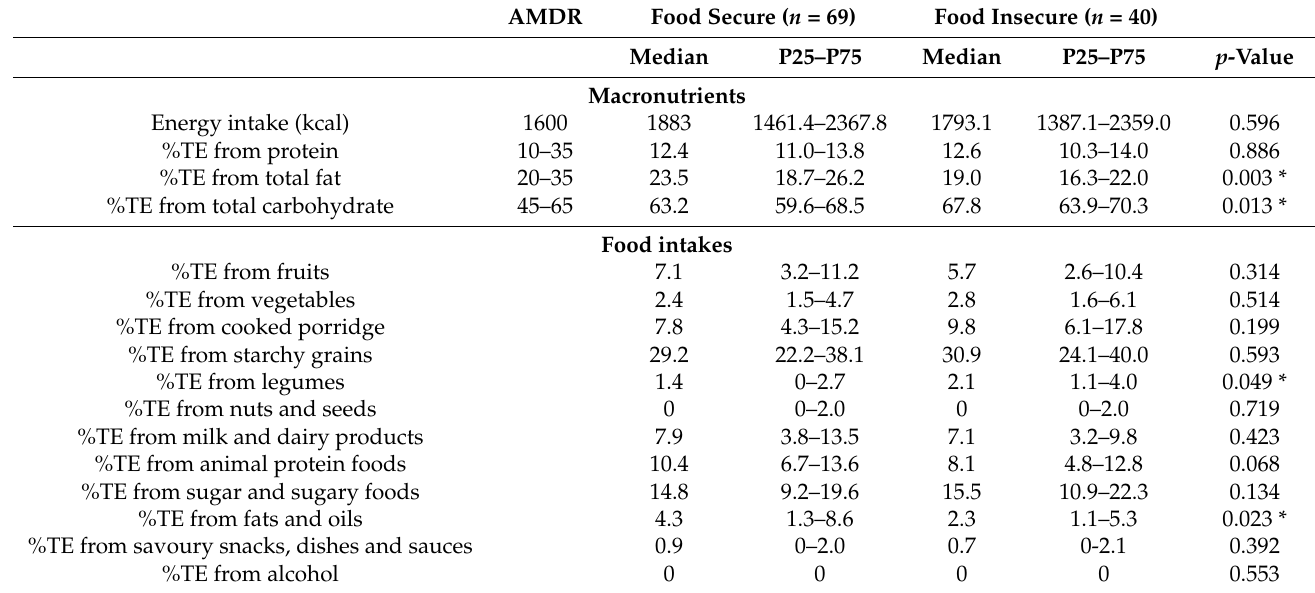
Table 4. Energy distribution of macronutrients and food intake of 12 selected food groups for urban older low-income South African